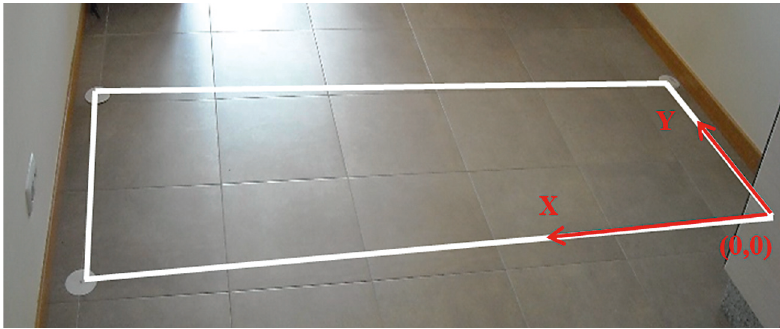
Figure 7: Picture of the test site showing the prospected grid (modified from